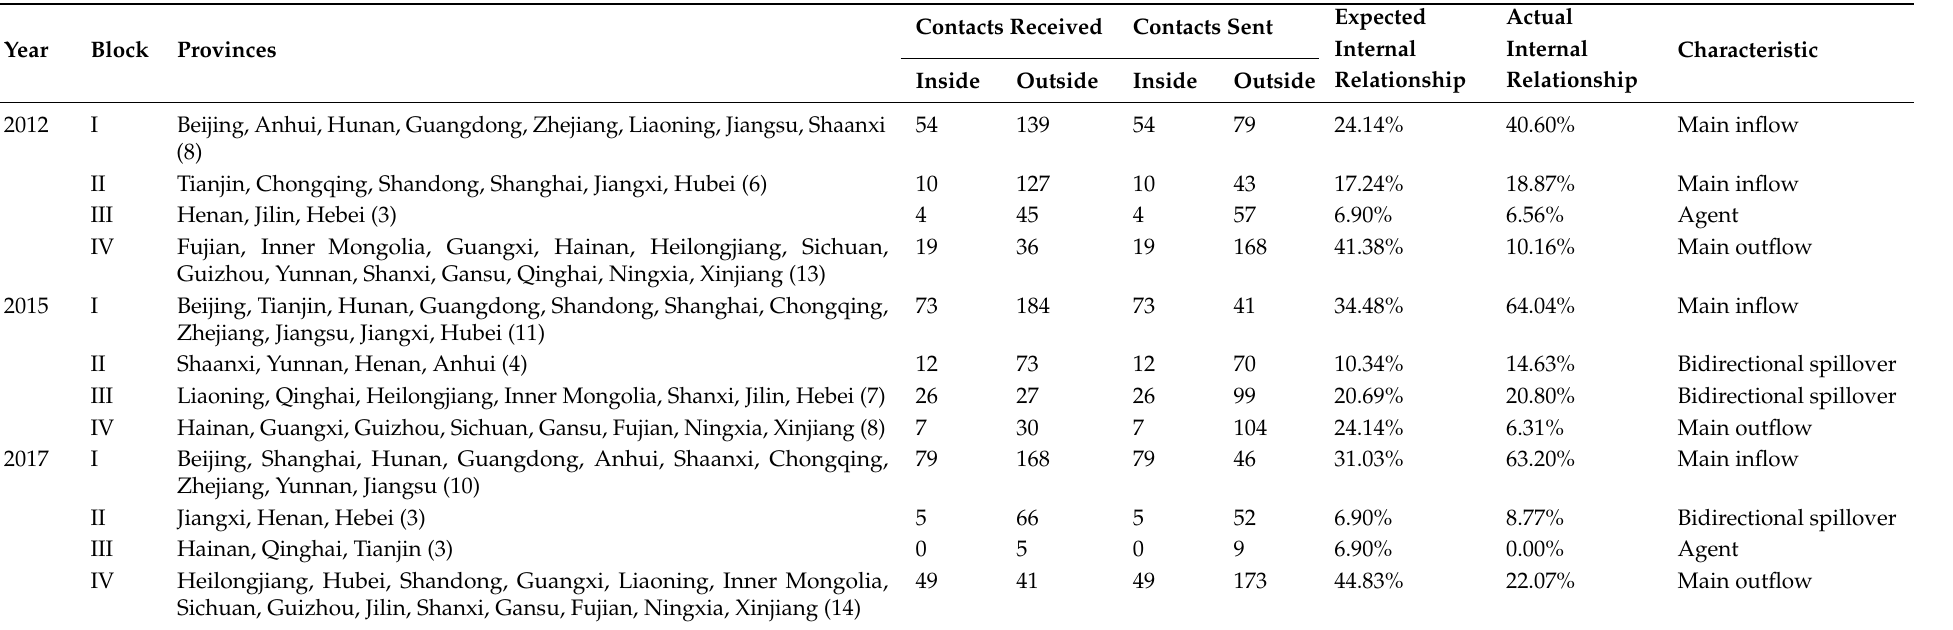
Table 3. Block division and spillover effects of